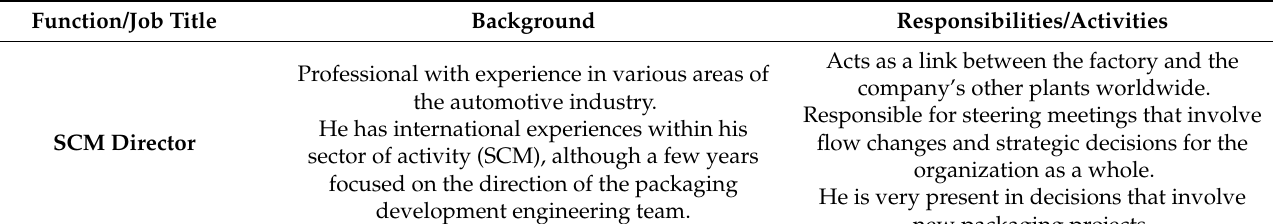
Figure 1. Hierarchical structure (organization chart) of the packaging engineering team at XPTO AUTOMOTIVE. Table 1. Expert panel (qualifications of the respondent sample).